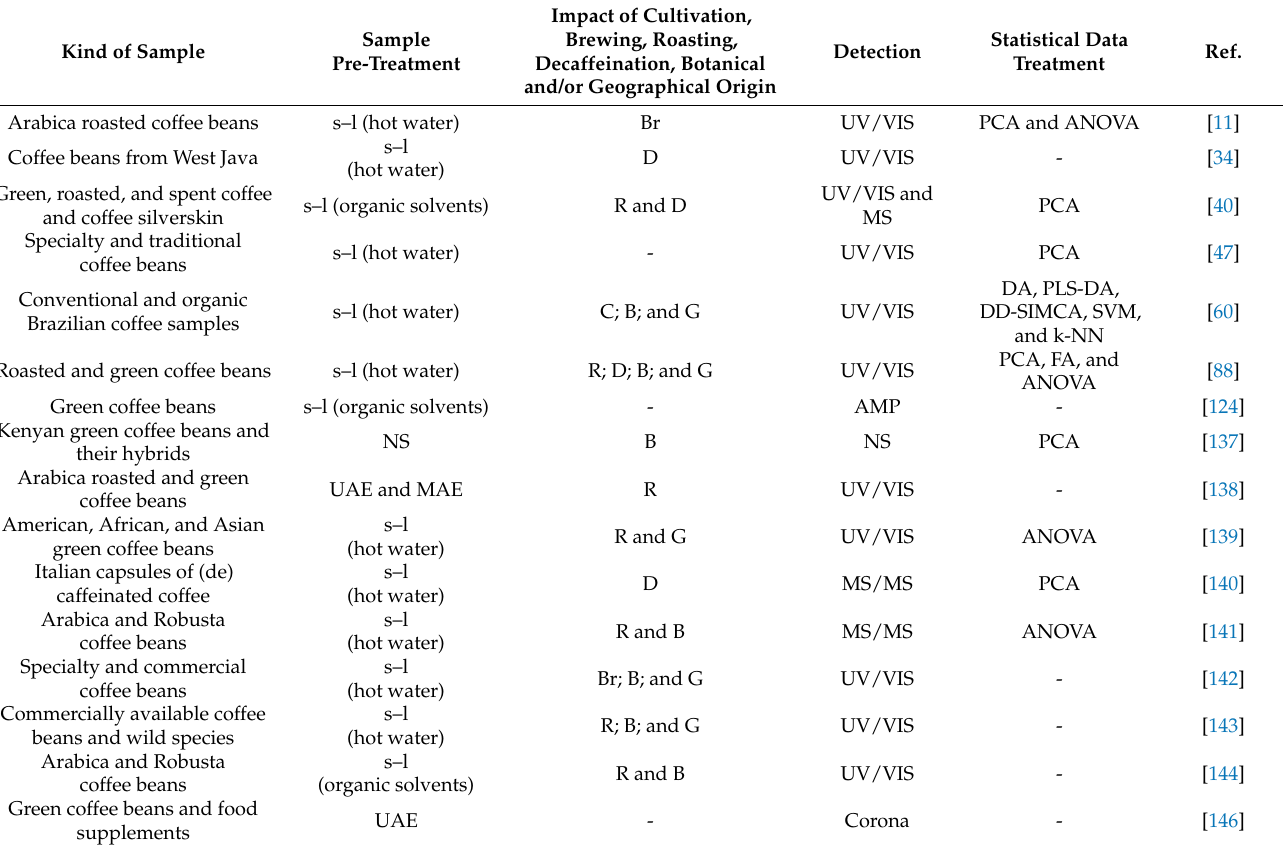
Table 1. Overview of targeted HPLC